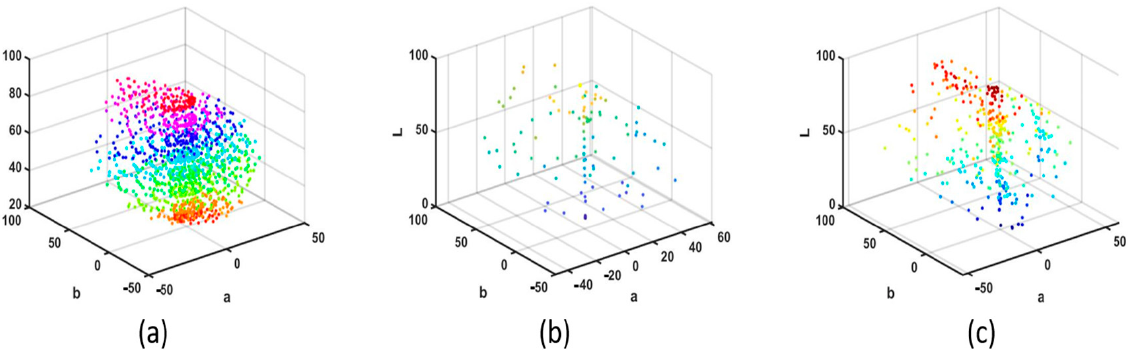
Figure 4. CIE Lab coordinate of ( a ) 1269 Munsell Matt chips, ( b ) the 140 ColorChecker SG and ( c ) the 354 Vrhel spectral dataset.